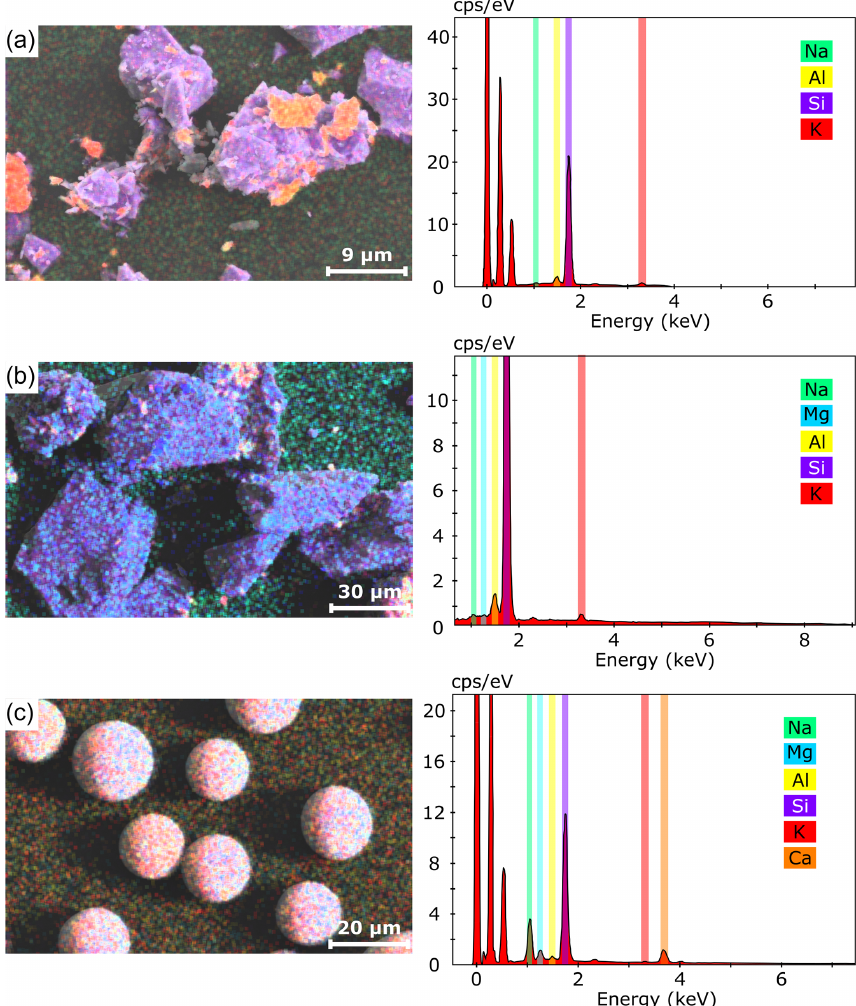
Figure 2. SEM qualitative analysis of the material composition. On the left is the backscattered electron (BSE) imaging, while on the right is the energy-dispersive detector (EDS) spectrum. A qualitative composition is presented for (a) silica powder, (b) crushed quartz and (c) glass microbeads. PVC powder has not been analyzed due to its complex